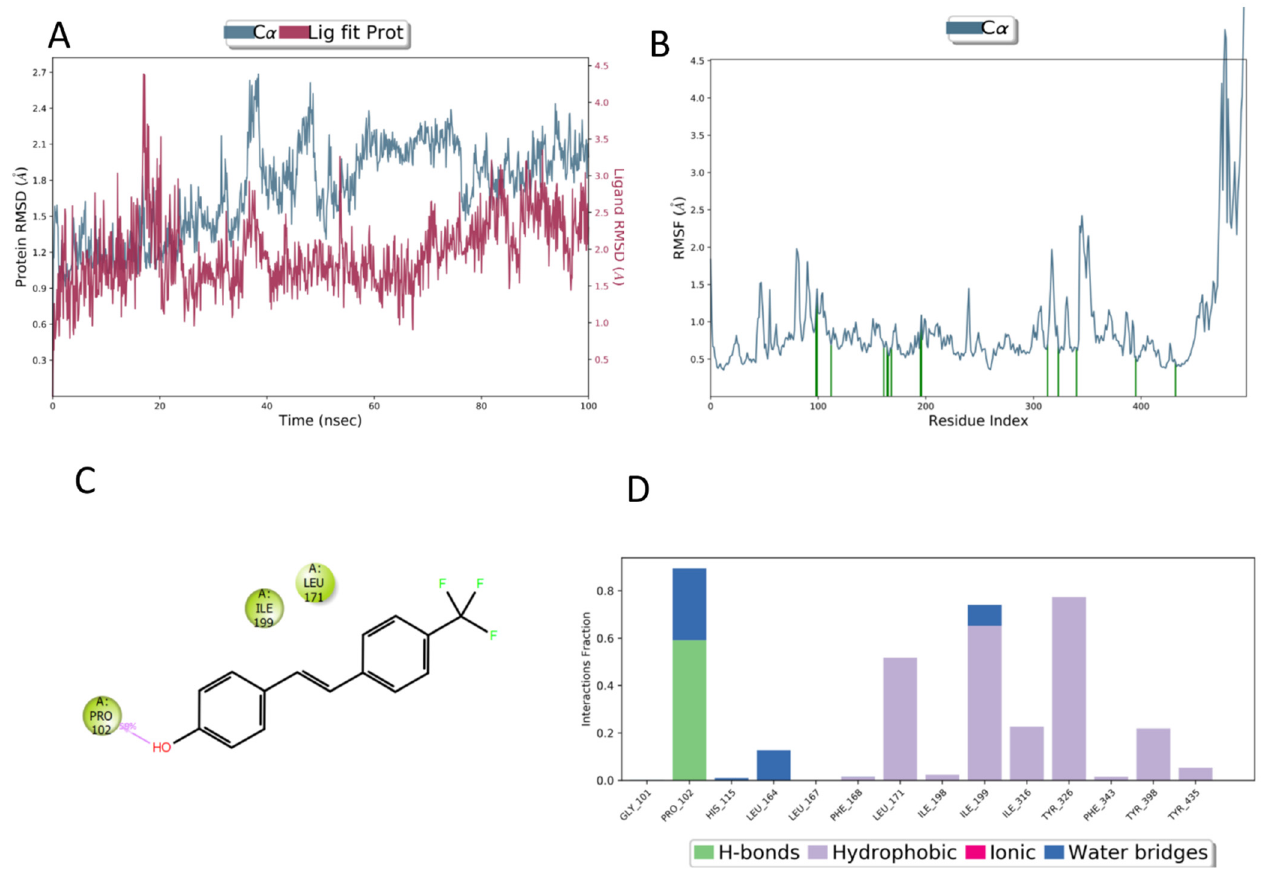
Figure 5. ( A ) RMSD evolution during the MD simulation of the protein (light blue, calculated on the C-alpha, left Y -axis) and the ligand (compound 5 ) (purple, calculated on all atoms, right Y -axis); ( B ) protein RMSF, green lines indicate residues involved in interactions with ligand 5 ; ( C ) 2D representation of most conserved ligand–protein interactions with the indication of the persistence (%) along the simulation; ( D ) depiction of the frequency and type of ligand–protein interaction along with the MD simulation. Ligand 5 forms a stable H-bond with Pro102.